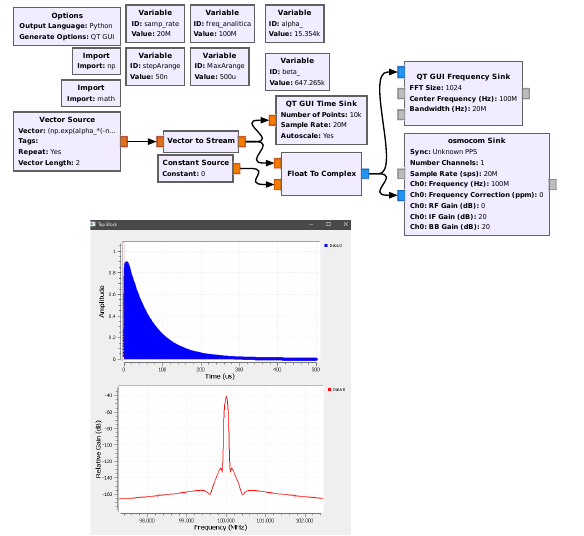
FIGURE 3. GNU Radio program and output plots (bottom).